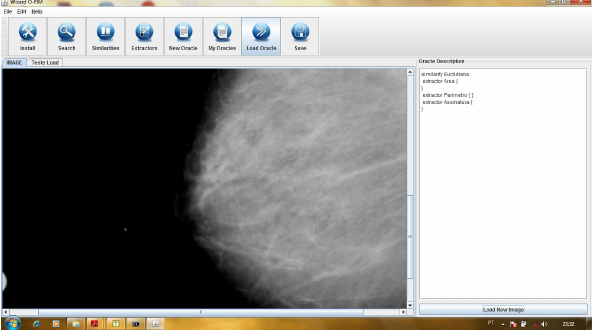
Figure 6. Graphical Interface for O-FIm Framework